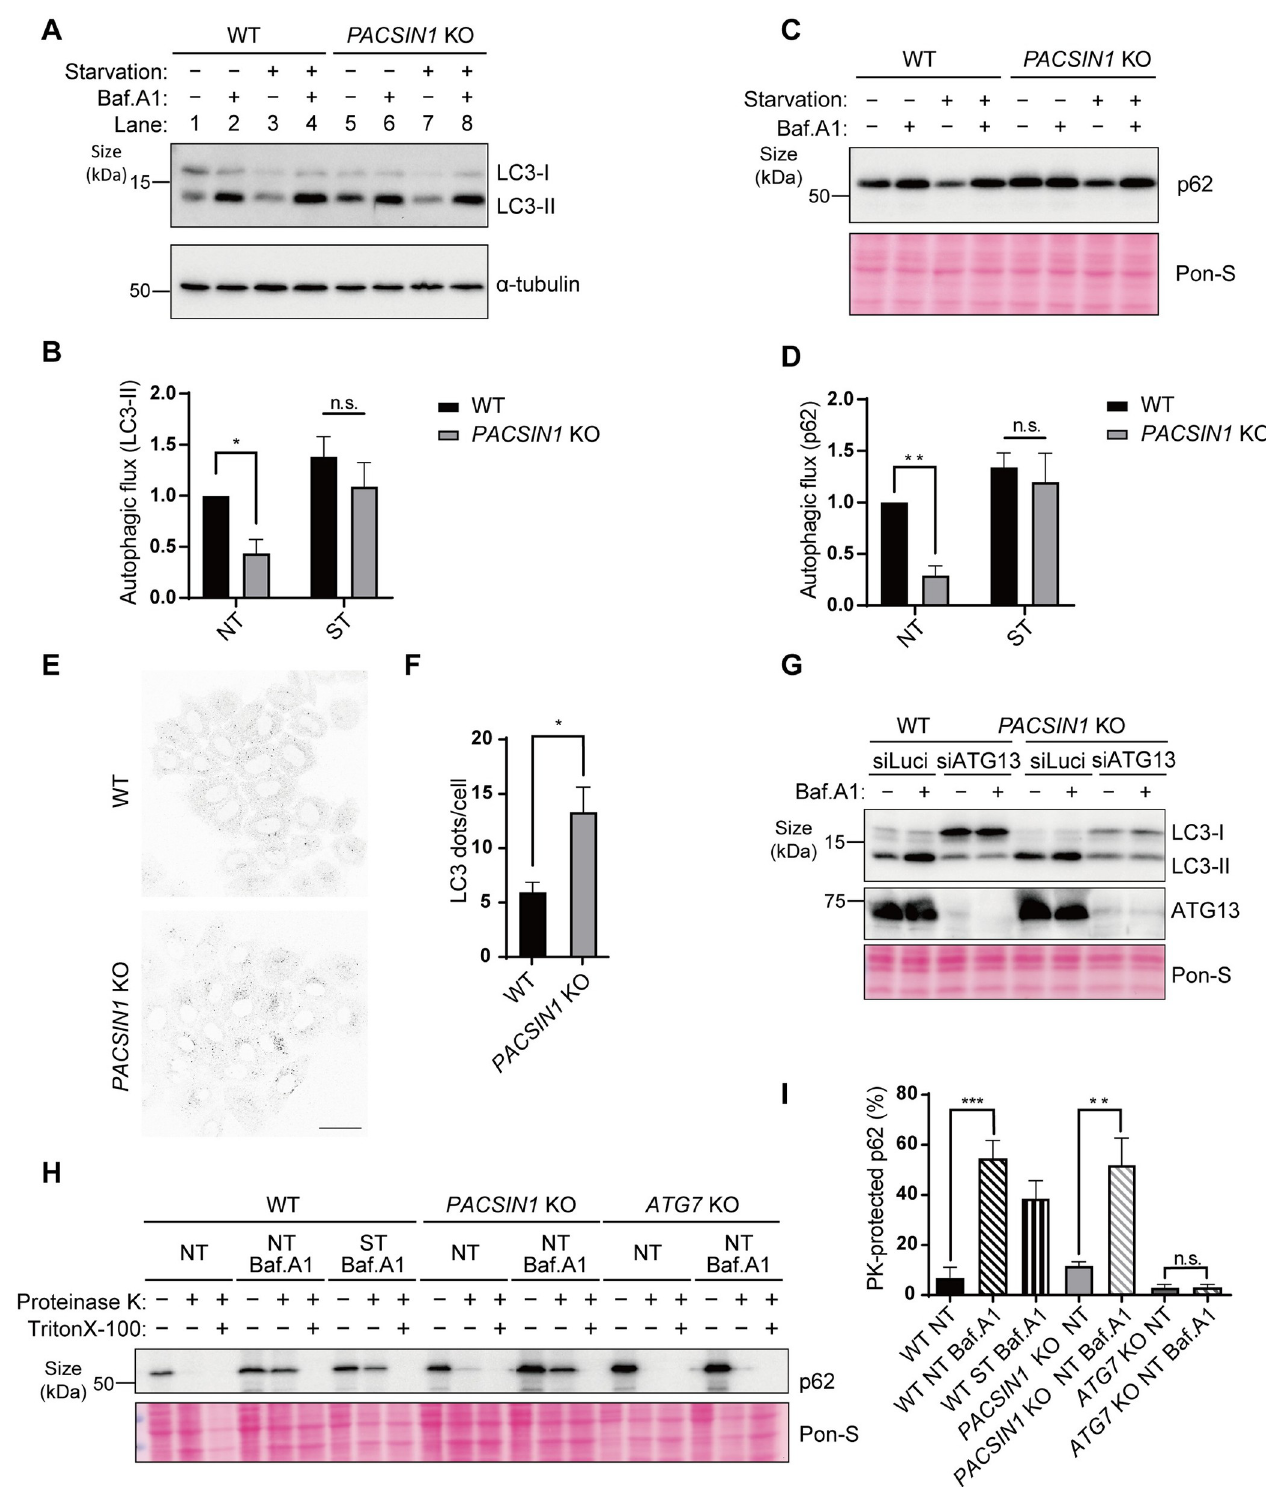
Fig 1. PACSIN1 is essential for autophagy. (A) WT or PACSIN1 clone #1 KO HeLa cells were cultured for 2 h in growth medium (DMEM, NT) or starvation medium (EBSS, ST) with 125 nM bafilomycin A1 (Baf.A1) and then analyzed by immunoblot using anti-LC3 and anti– α -tubulin antibodies. (B) The quantification of LC3 flux is expressed as mean ± s.e.m (n = 3). n.s.; not significant, � p < 0.05 (multiple t-test). (C) WT or PACSIN1 KO HeLa cells were cultured for 6 h in growth medium (NT) or starvation medium (ST) with 125 nM Baf.A1 and then analyzed by immunoblot using anti-p62. Pon-S, Ponceau S